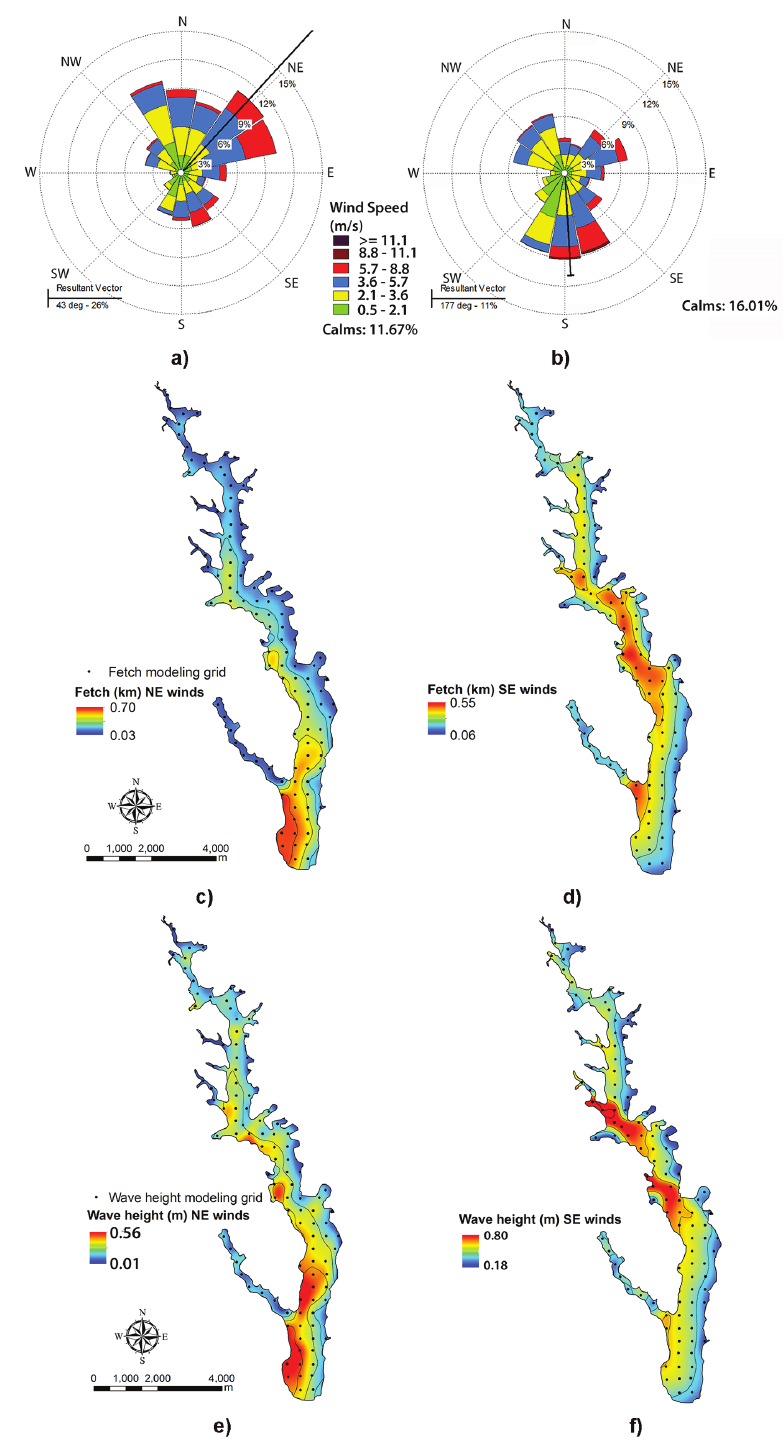
Figure 5 - Wind roses for Linhares meteorological station (A614) based on hourly records for 2007 to 2009: a) wet and warm season and b) dry and cool season (Barroso et al. 2014). Fetch models: c) NE wind and d) SE wind. Wave height (m) models: e) NE Wind and f) SE